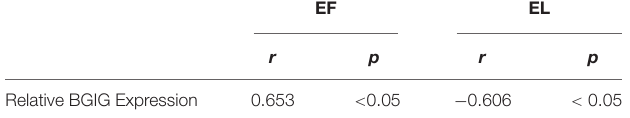
TABLE 2 | Correlation between relative BGIG expression and copulatory behavior. EF EL r p r p Relative BGIG